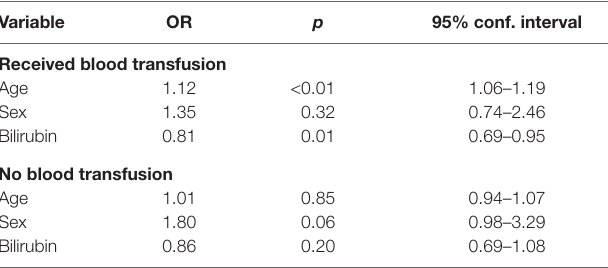
TaBle 2 | Predictors of worsening Ma/cr levels stratified by transfusion history during the study period. Variable Or p 95% conf. interval